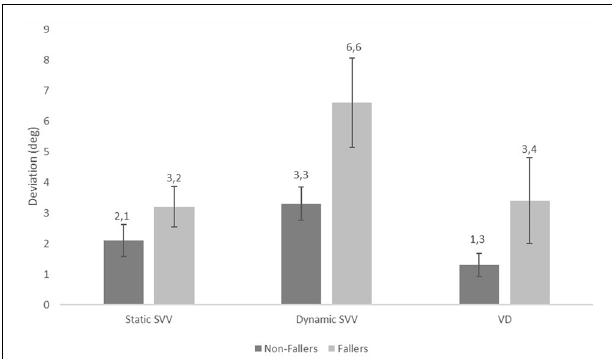
FIGURE 2 | The mean values of static Subjective Visual Vertical (SVV), dynamic SVV tilts, and Visual Dependence (VD) assessment in the non-faller and faller groups. Vertical columns show the mean of the measurements, and vertical bars show the 95% confidence intervals ( p = 0.012 for static SVV tilts, p < 0.001 for dynamic SVV tilts, p = 0.014 for